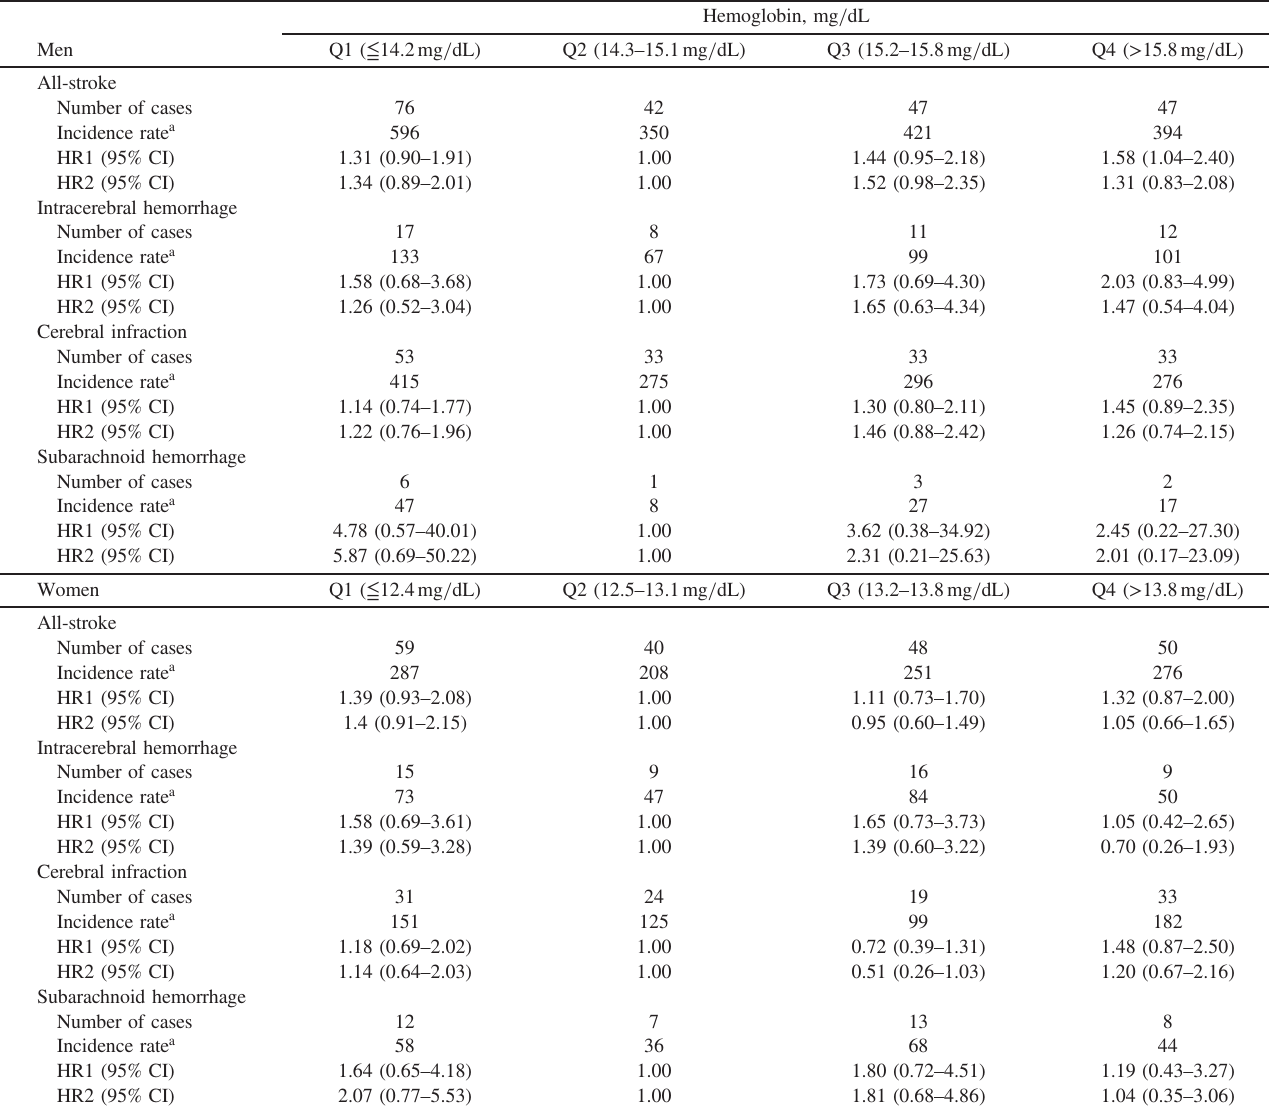
Table 3. Hazard ratios based on Hemoglobin and adjusted for potential confounders for both the sexes